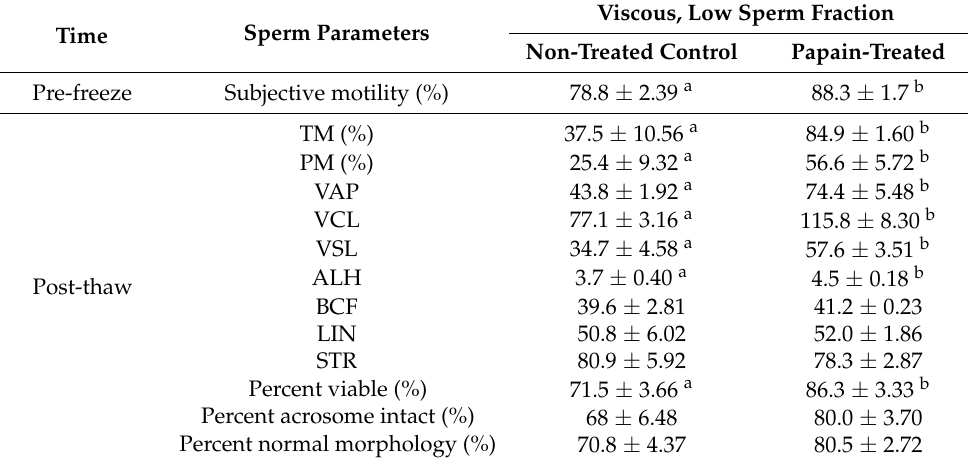
Table 2. Sperm characteristics of viscous, low sperm control and papain-treated samples collected from southern white rhinoceros bulls (n = 3 bulls, 4 ejaculates) assessed prior to and following cryopreservation (Exp 1). Percent viability, acrosome intact and normal morphology was assessed subjectively. Data are mean ± SEM. Columns which differ in superscript indicate significant differ- ences between the viscous control and viscous treated samples ( p < 0.05). Viscous, Low Sperm Fraction Time Sperm Parameters Non-Treated Control